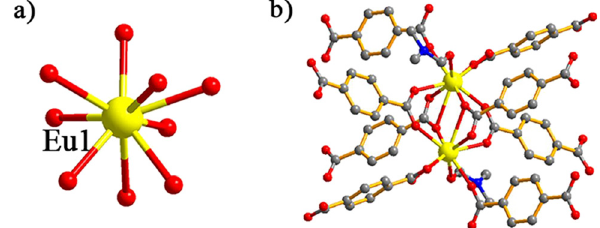
Table  : Data collection and